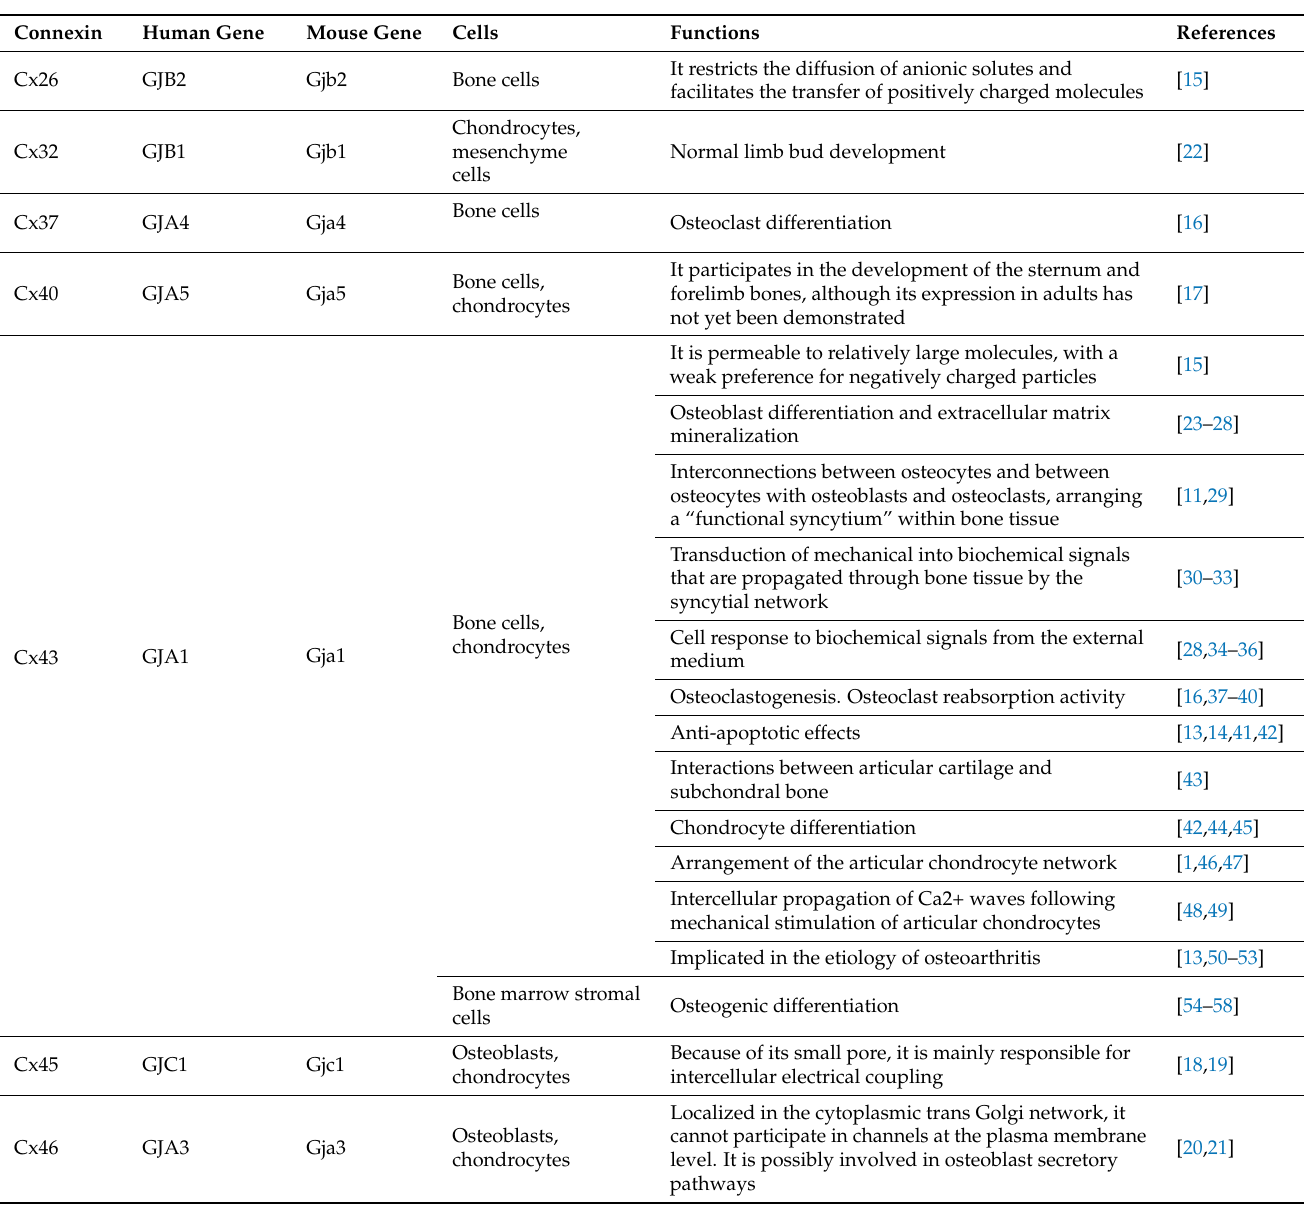
Table 1. Connexins (Cxs) mainly expressed in osteo-chondral cellular